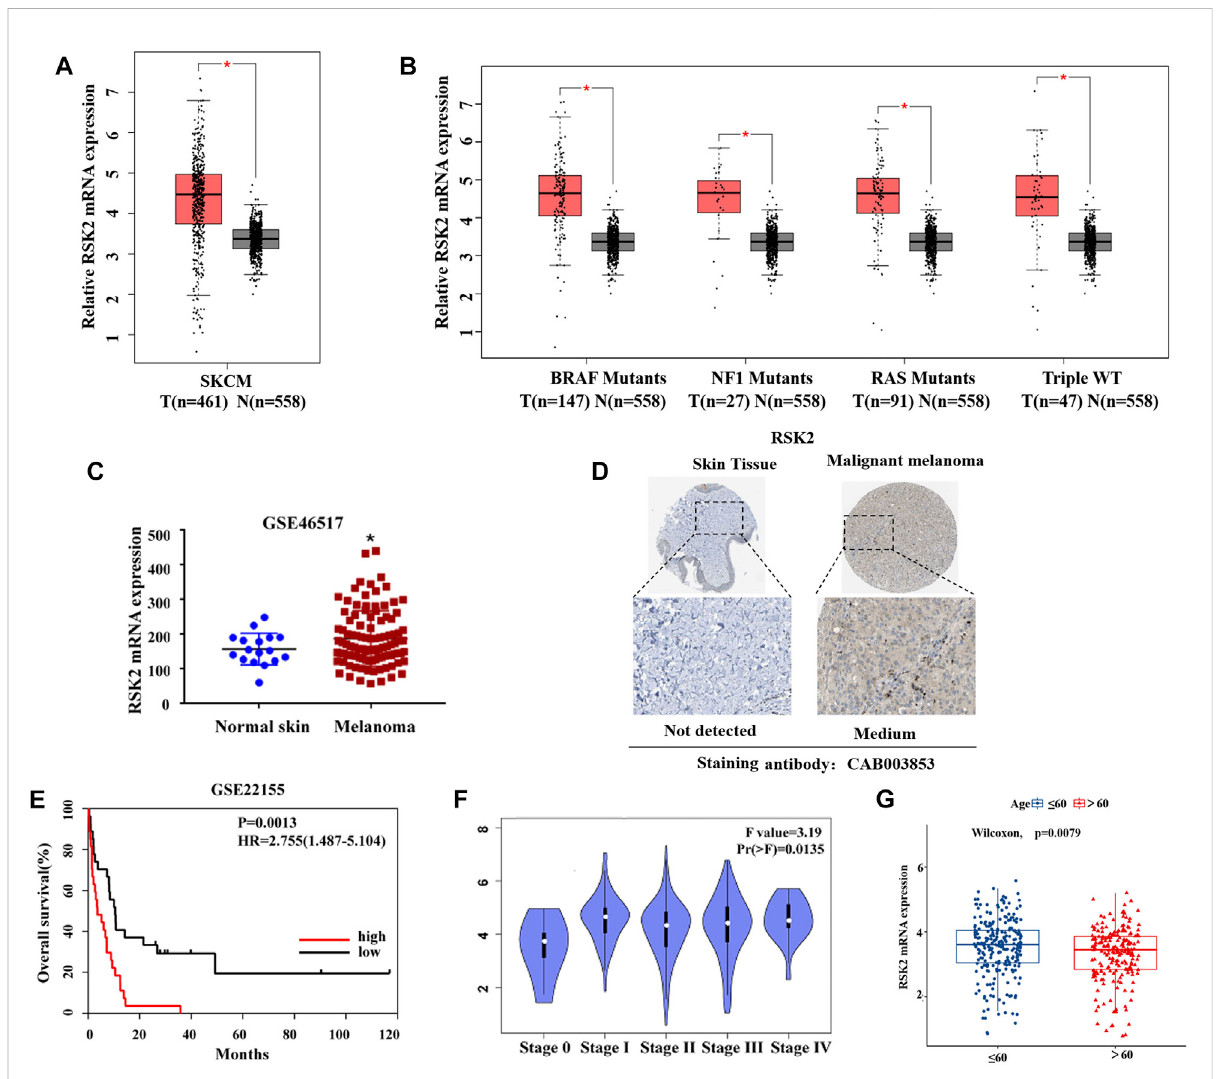
FIGURE 1 RSK2 is upregulated and is associated with poor prognosis in melanoma. (A) The relative expression of RSK2 mRNA in normal and melanoma tissues was analyzed by GEPIA2 database. (B) The relative expression of RSK2 mRNA in different subtypes of melanoma and normal skin tissues was analyzed by GEPIA2 database. (C) The mRNA levels of RSK2 in normal and melanoma tissues were analyzed by GEO dataset (GSE46517). (D) The proteinlevelsofRSK2innormalandmelanomatissueswereanalyzedbytheHumanProteinAltasdatabases. (E) TheprognosticvalueofRSK2in melanoma patients in the overall survival was analyzed by GEO dataset (GSE22155). (F) The association of RSK2 mRNA expression with the clinical stage of melanoma was analyzed by GEPIA2 database. (G) The association of RSK2 mRNA expression with the age of melanoma patients in TCGA. Values represented as mean ± SD. p p < 0.05, pp p < 0.01 vs. the Con